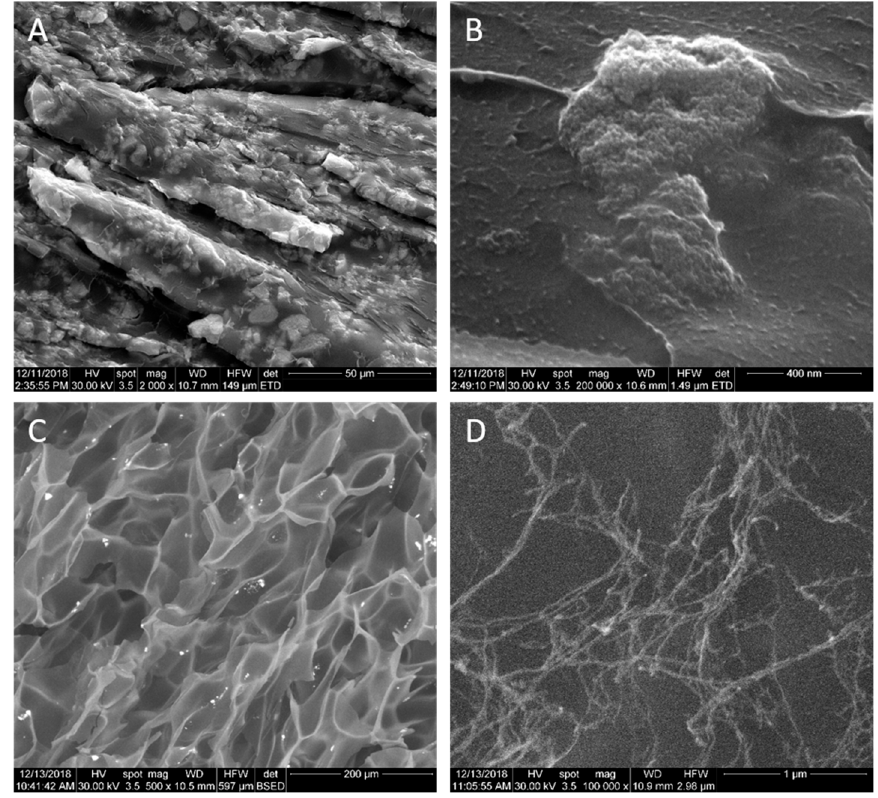
Figure 8. SEM micrographs of PAA-MMNPs 90:10 block hydrogel ( A , B ) and lyophilized PAA-MMNPs 90:10 hydrogel ( C , D ).